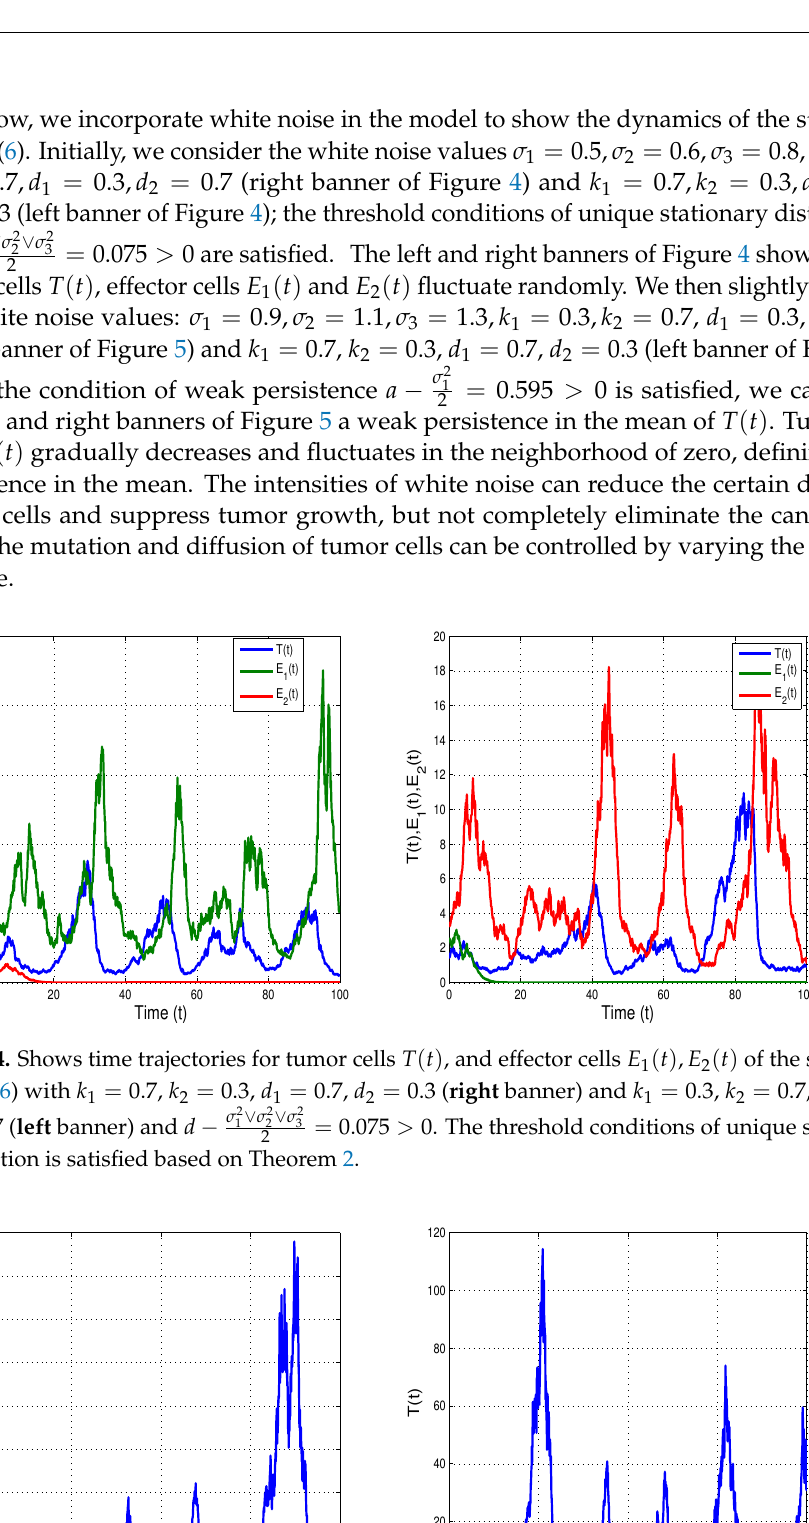
Figure 5. Shows time trajectories for tumor cell T ( t ) of the stochastic model (6) with k 1 = 0.7, k 2 = 0.3, d 1 = 0.7, d 2 = 0.3 ( right banner) and k 1 = 0.3, k 2 = 0.7, d 1 = 0.3, d 2 = 0.7 ( left banner) and 2 = 0.595 > 0. The weak persistence condition is satisfied under Remark 1. a − σ 1 2 By increasing the white noise values σ 1 = 1.5, σ 2 = 1.6, σ 3 = 1.8, k 1 = 0.3, k 2 = 0.7, d 1 = 0.3, d 2 = 0.7 (right banner of Figure 6) and k 1 = 0.7, k 2 = 0.3, d 1 = 0.7, d 2 = 0.3 (left